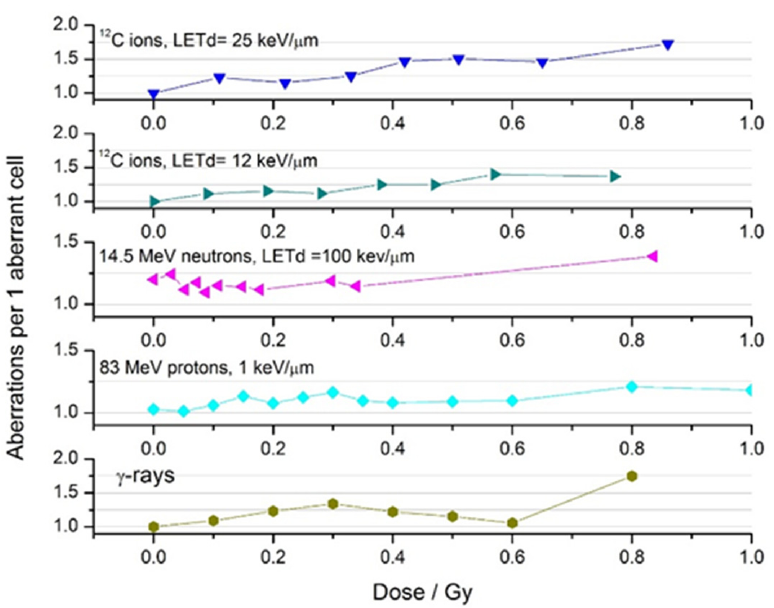
Figure 6. Number of chromosome aberrations per aberrant cell in CHO-K1 cells exposed to low doses of radiations with different LET values.